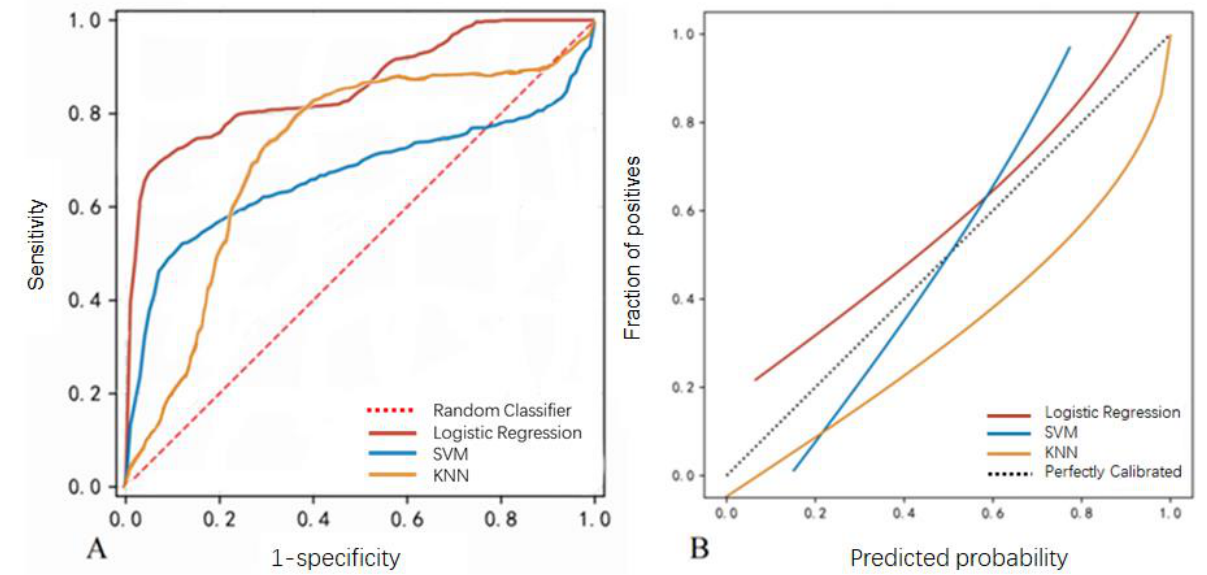
Figure 4. Model performance using the validation dataset. ( A ) The ROC curve of the logistic regression, SVM, and KNN models. ( B ) Calibration curves of the EVD-associated infection prediction. The y -axis meant the diagnosed infection. The x -axis meant the predicted risk of infection. The diagonal dotted line meant a perfect prediction by an ideal model. The solid line represented the performance of logistic regression, SVM, and KNN models, which indicated that a closer fit to the diagonal dotted line represented a better prediction.